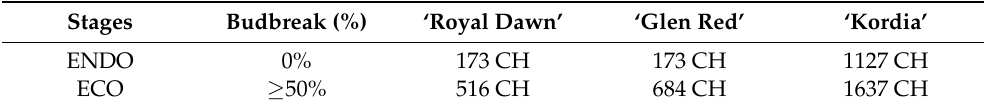
Table 1. Determination of dormancy stages of sweet cherry varieties analyzed in this study at different chilling hours (CH) accumulation. Stages Budbreak (%) ‘Royal Dawn’ ‘Glen Red’ ‘Kordia’ ENDO 0% 173 CH 173 CH 1127 CH ECO ≥ 50% 516 CH 684 CH 1637